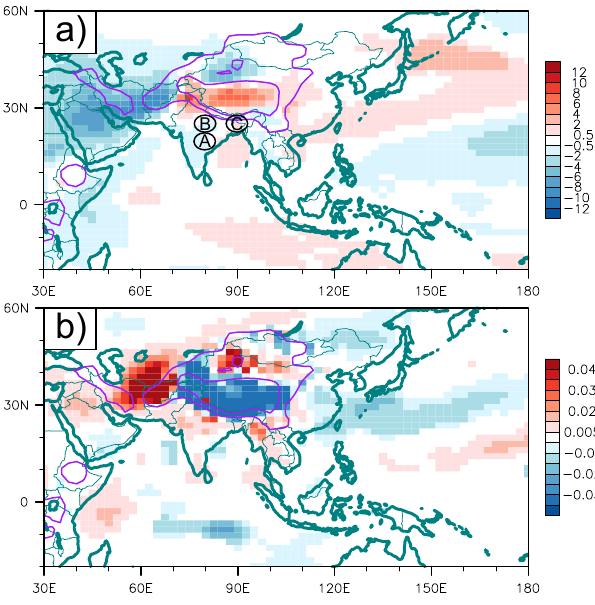
Figure 4. JJA difference in low-level entropy (Equivalent potential temperature on a terrain-following model level about 20 hPa above the surface) (K) (a) and vertical velocity at 500 hPa (Pa/s) (b) for FULL_TP minus NO_TP. Red indicates positive anomaly. Blue indicates negative anomaly. For vertical velocity, positive anomaly means more descent. Only significant values at P<0.05 are shown. Letters A, B, and C indicate the locations of the three points used in Table 1, respectively. Purple contour lines denote the elevations of 1200 meter and 3000 meter.